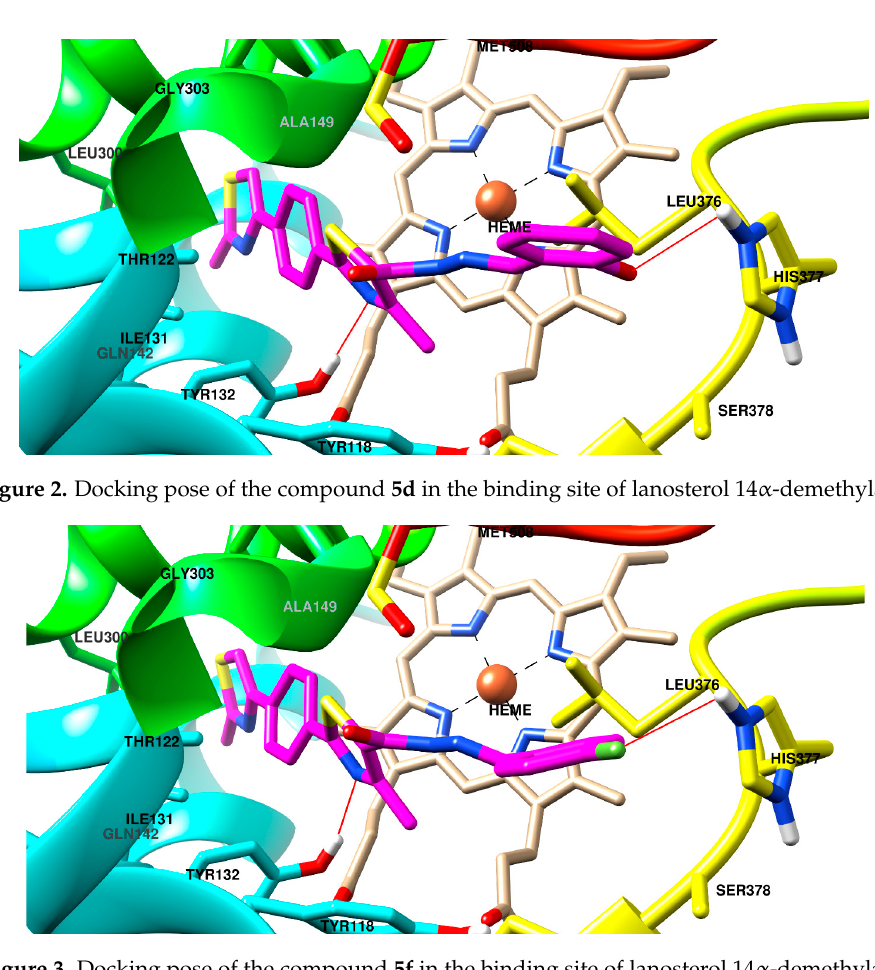
Figure 3. Docking pose of the compound 5f in the binding site of lanosterol 14 α -demethylase.